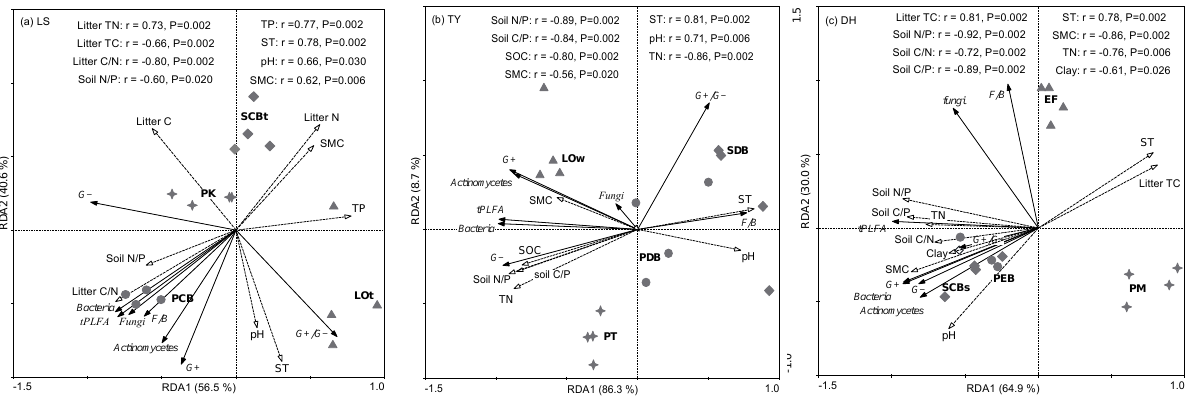
Figure 4. Redundancy analysis (RDA) ordination biplot of soil microbial community structure and environmental properties for different forest types in different climatic zones ( a Liangshui; b Taiyue; c Dinghu). Only the environmental variables that were significantly correlated with RDA1 are shown. The dotted lines and solid lines represent the environmental variables and lipid signatures. The abbreviations of the variables included in this figure are shown in Fig.